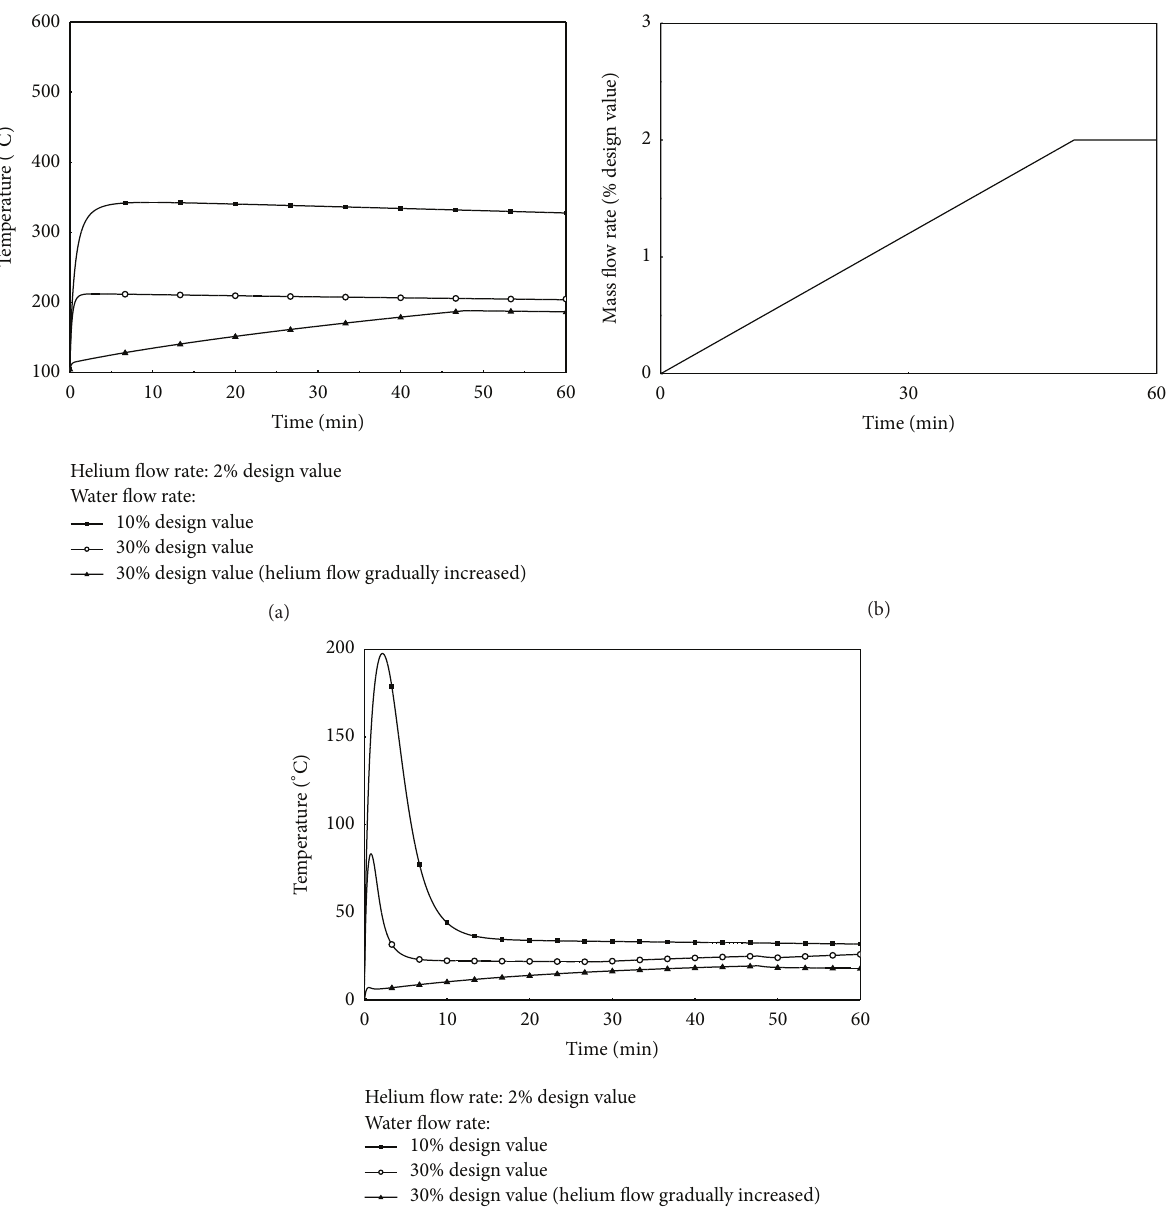
Figure 13: Temperature transient of SG outlet during cooling of reactor core; water inlet temperature: 105 ∘ C; pressure: 13.9 MPa; helium mass flow rate: 2%; and design value: (a) temperature at SG outlet; (b) mass flow rate of helium; and (c) temperature difference between tube sheet and steam